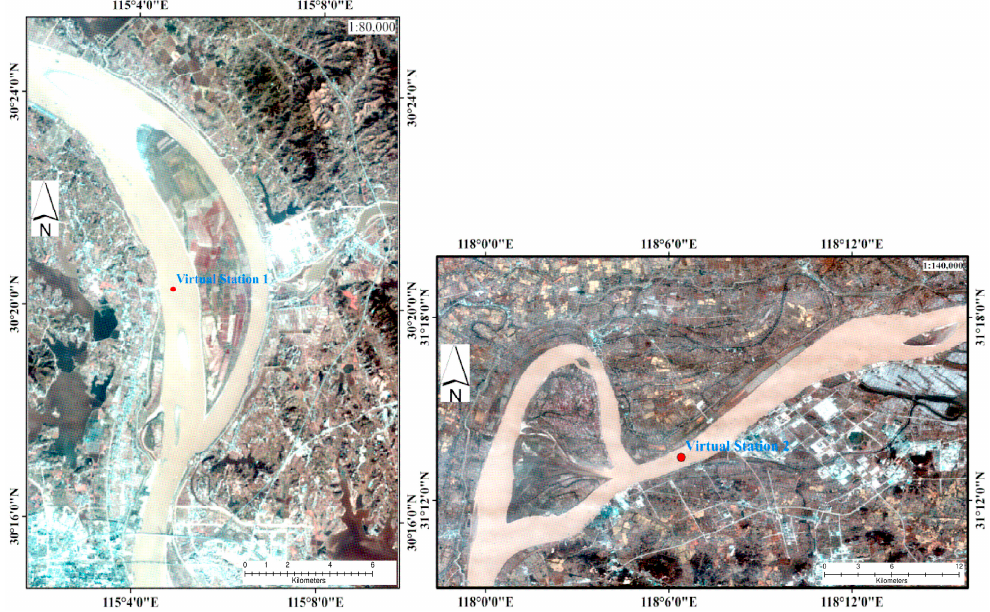
Figure 2. The site characteristics at virtual stations 1 and 2 derived from a true color Landsat 8 image acquired on the 14 October 2014.